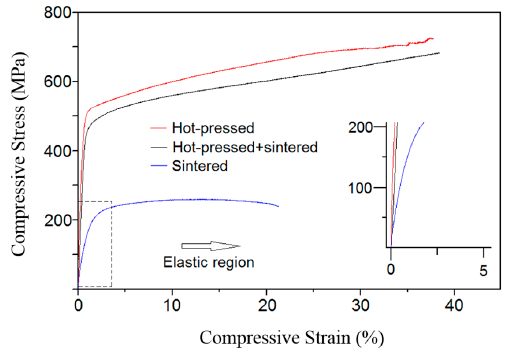
Figure 3. Typical stress–strain curves of samples produced by green compaction (50 kN) and sintering at 1000 ◦ C followed by water quenching, hot-pressing at 600 ◦ C with 50 kN and by hot-pressing at 600 ◦ C with 50 kN followed by sintering at 1000 ◦ C and water quenching, obtained by compression